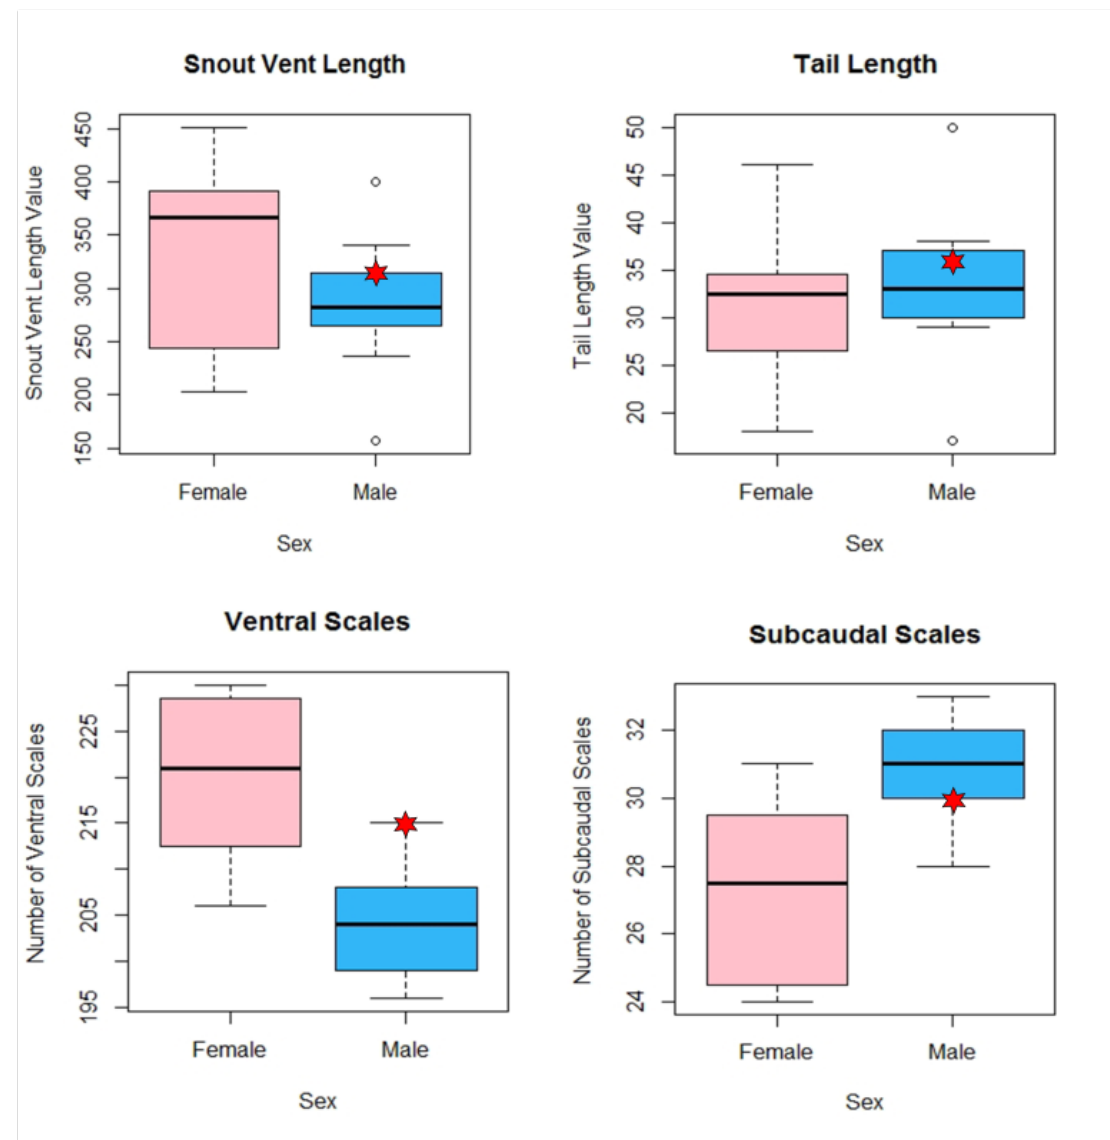
Fig. 6. Apostolepis albicollaris Lema, 2002, sexual dimorphism in morphometric (SVL, TL) and meristic (ventrals, subcaudals) characters. Outliers are indicated as circles, A. cerradoensis Lema, 2003 holotype indicated as red